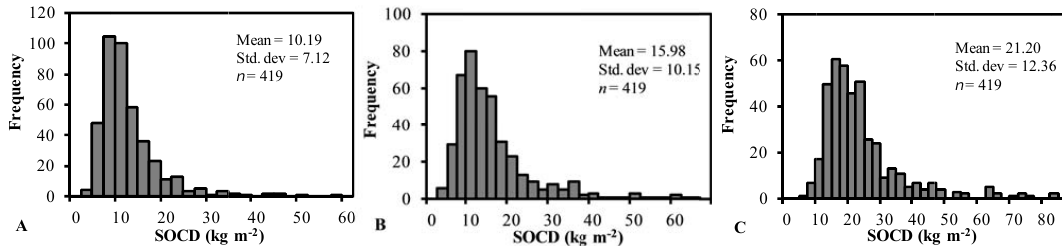
Figure 3. Frequency distributions of SOCD at different soil depth ranges ( (a) : 0–30cm; (b) : 0–60cm; (c) : 0–100cm).